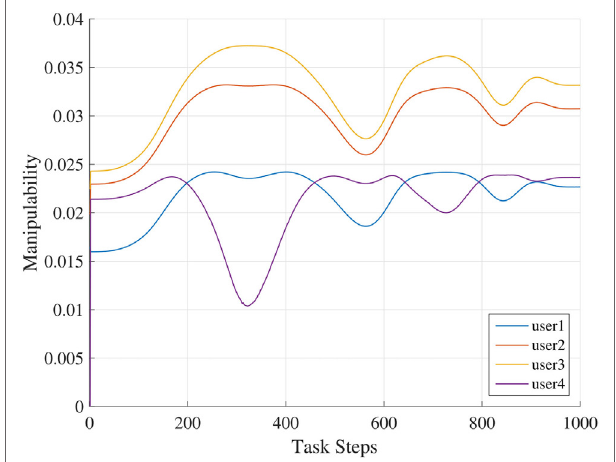
FigUre 9 | Manipulability variation within selected users while performing the drawing